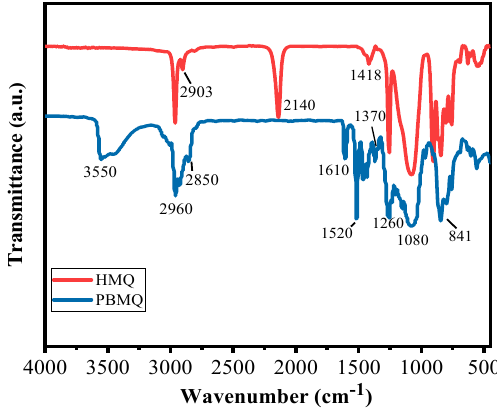
Figure 2. Infrared spectra of HMQ and